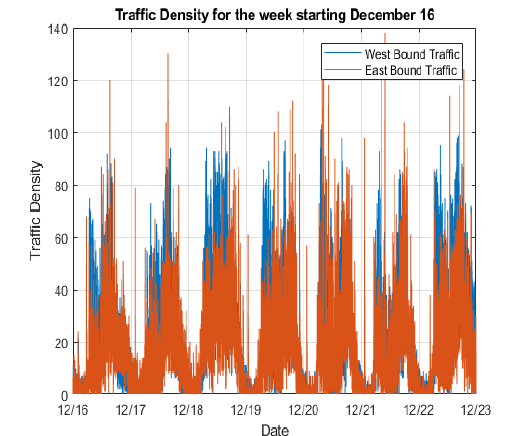
Figure 4. Traffic Density for one week